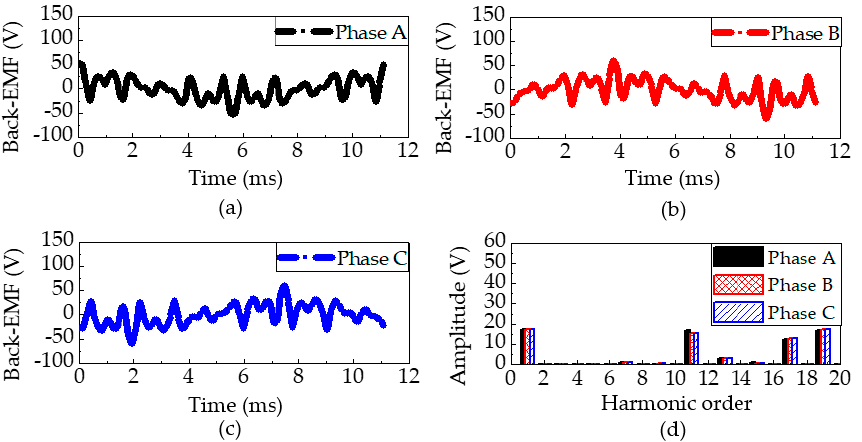
Figure 8. Characteristics of no-load back-EMF with 90 Hz in the outer winding when the output rotor and the inner winding operate at 1662 rpm and 270 Hz, respectively: ( a ) Waveforms of phase A; ( b ) Waveforms of phase B; ( c ) Waveforms of phase C; ( d ) Time harmonic spectra.